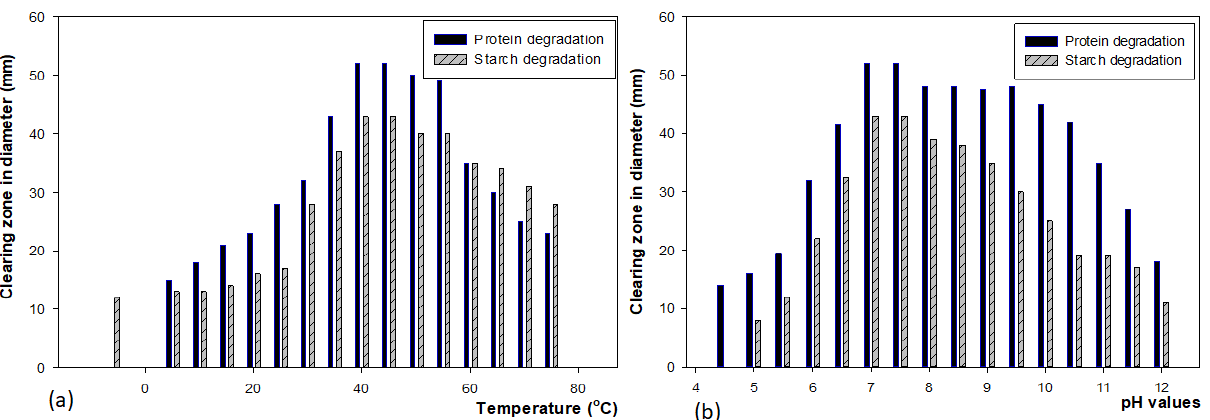
Figure 3. The effect of temperature ( a ) at pH 7–7.5 and pH values ( b ) at 45 °C for 4 d on protein and starch degradation.